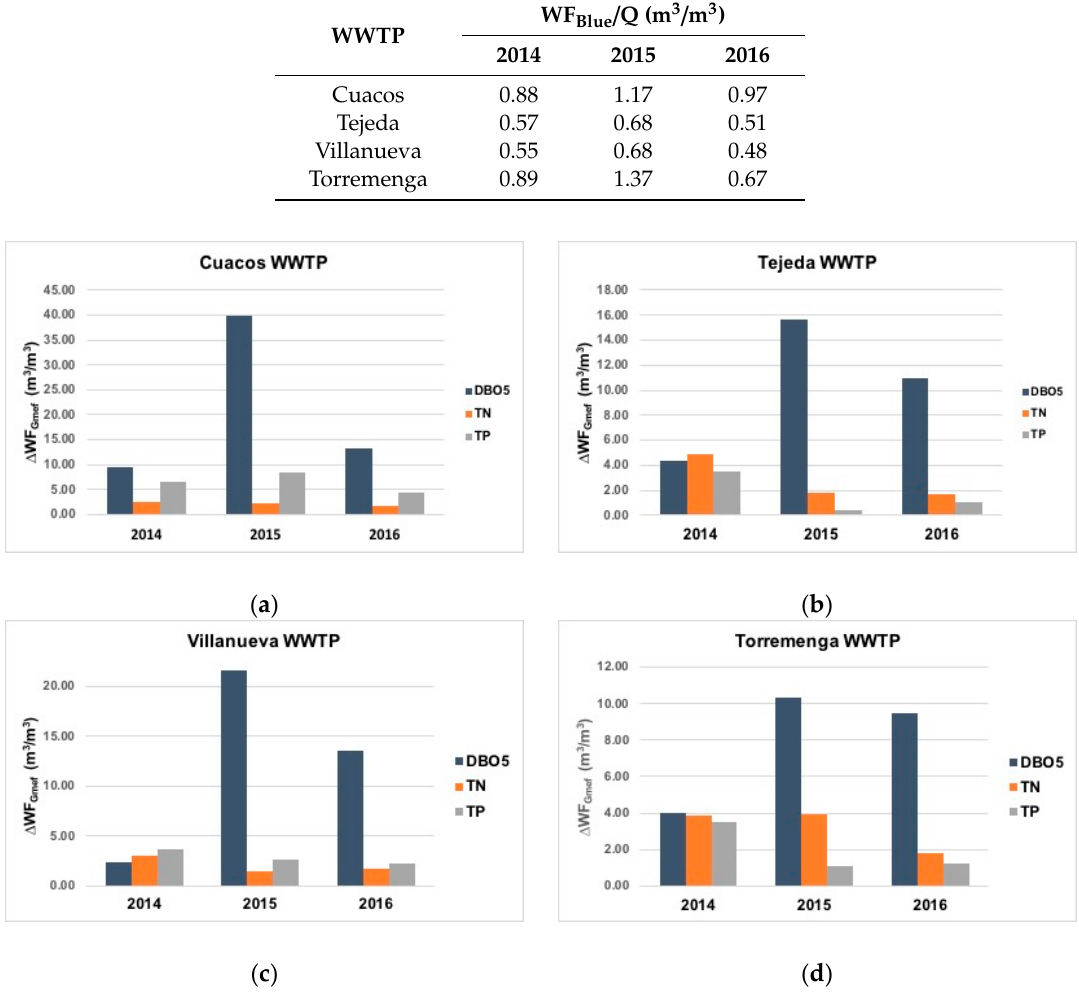
Table 4. Average monthly values of WF Blue per cubic metre of treated water, 2014–2016. WWTP